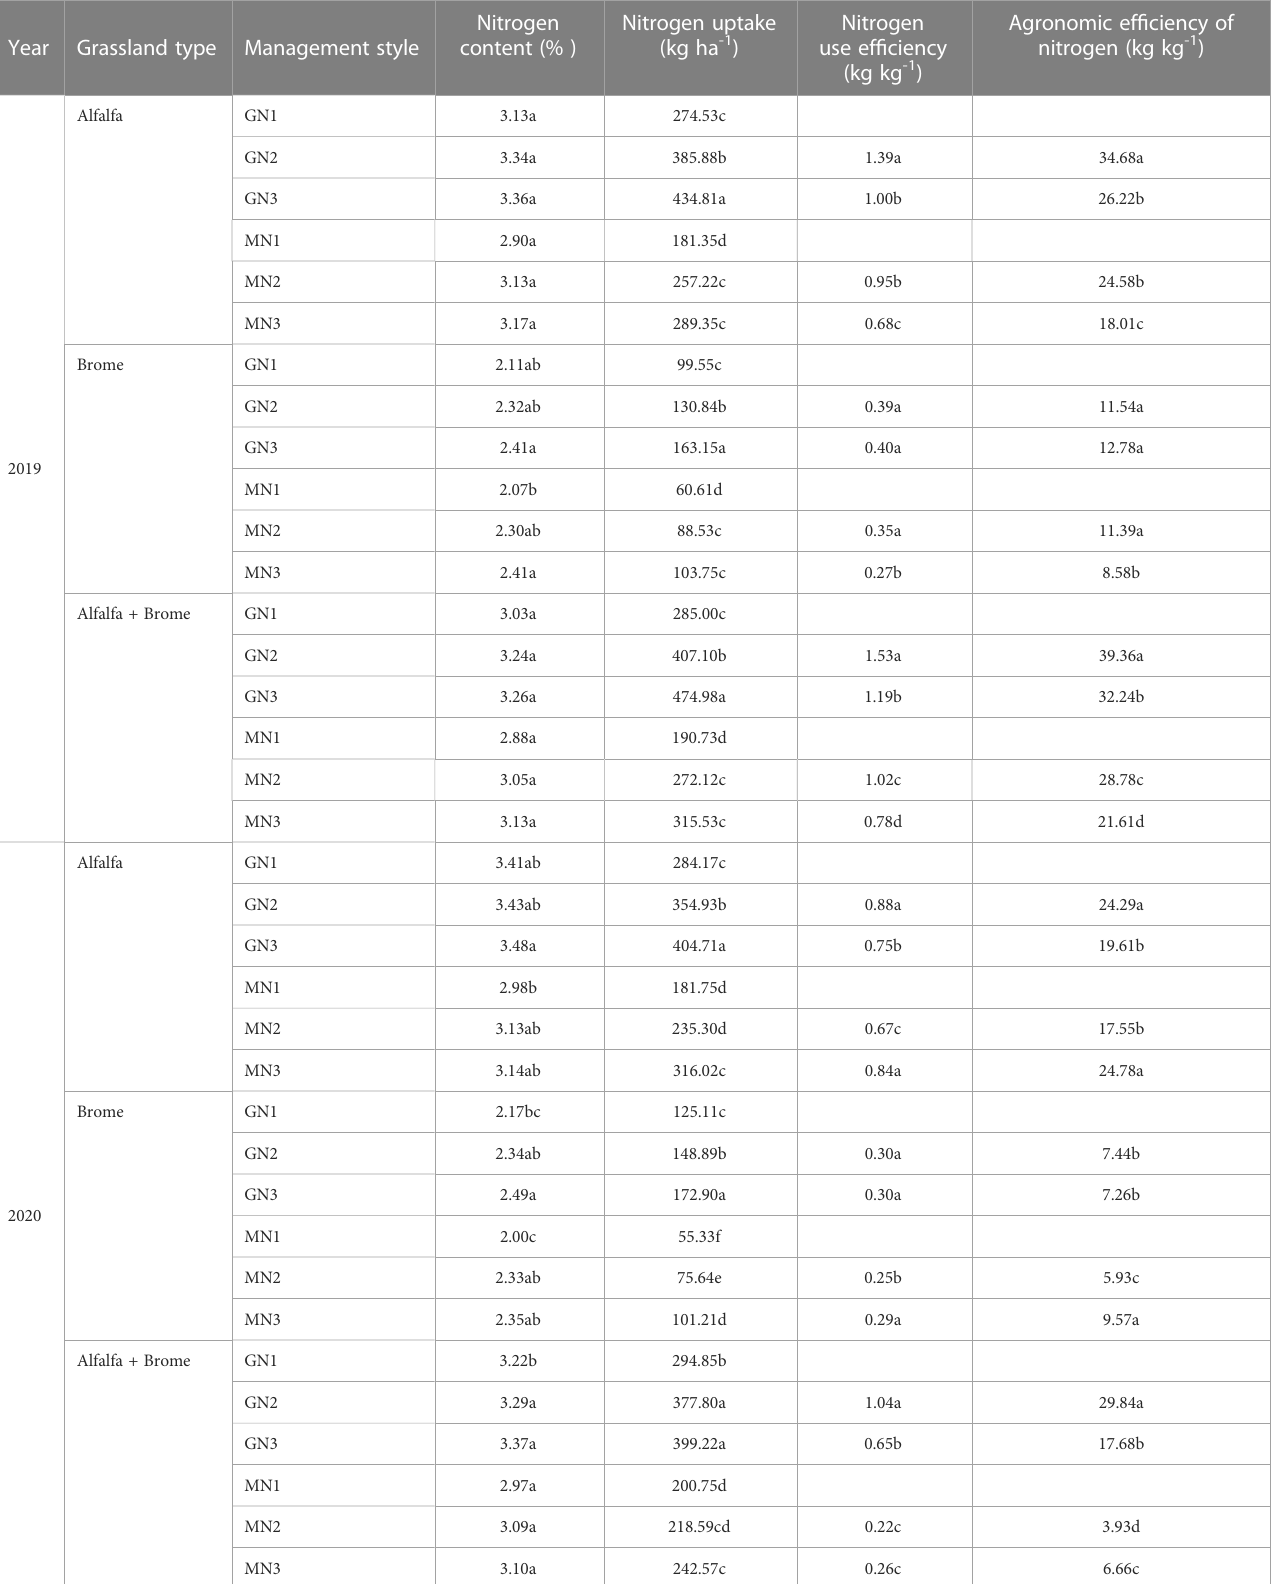
TABLE 4 Nitrogen uptake, nitrogen content, nitrogen use ef fi ciency and agronomic ef fi ciency of nitrogen under different treatments in 2019 and